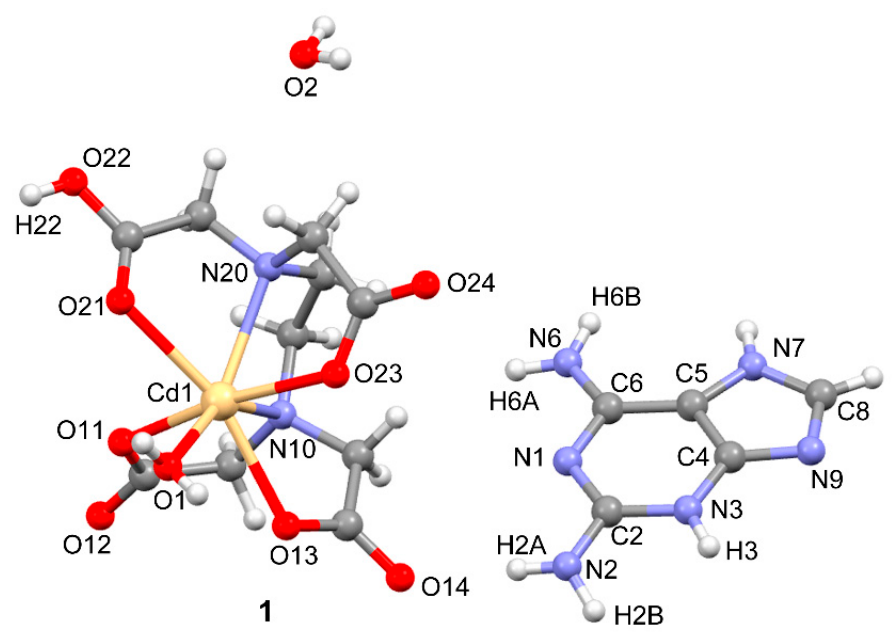
Figure 2. Asymmetric unit in the crystal of compound 1 , with relevant atom numbering scheme. Table 3. Coordination bond lengths (Å) and angles ( ◦ ) in the crystal of compound 1 , H 2